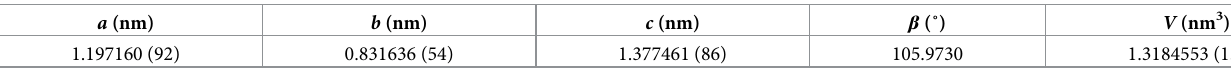
The a , b , and c represent the crystal-axes length, and β shows the angle between the crystal axes a and c . The unit-cell volume is shown as V